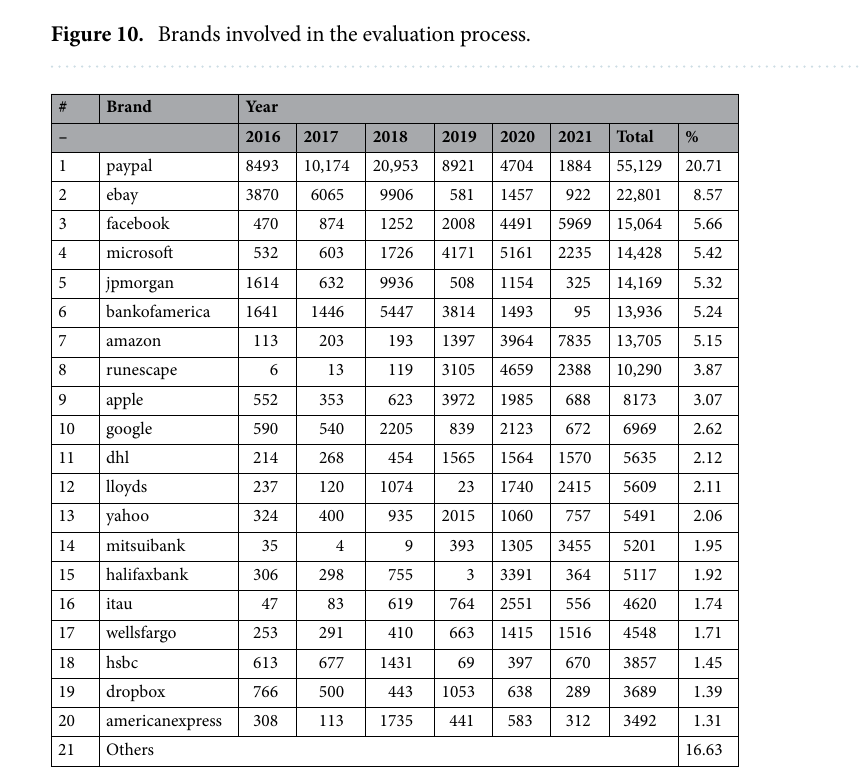
Table 4. Top 20 brands involved in the evaluation